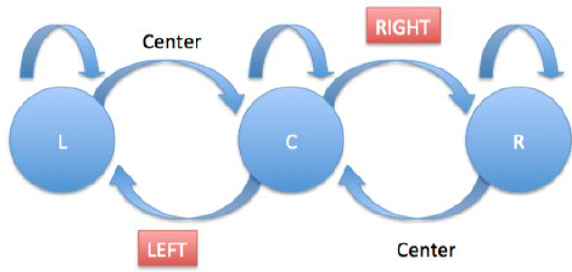
Figure 13. Flow chart for eyeControl algorithm